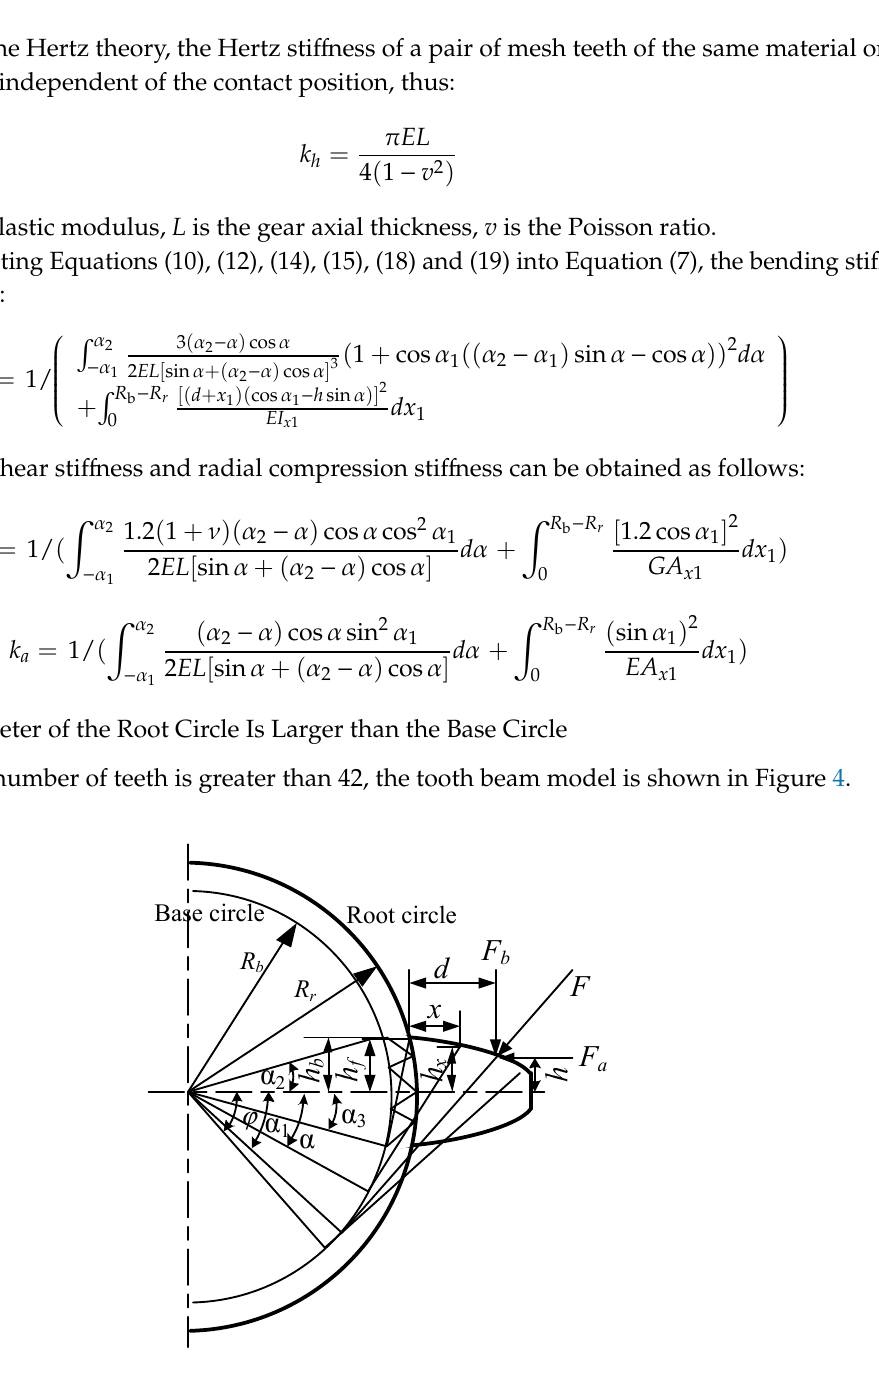
Figure 4. The force diagram of gear when the number of teeth is greater than 42.